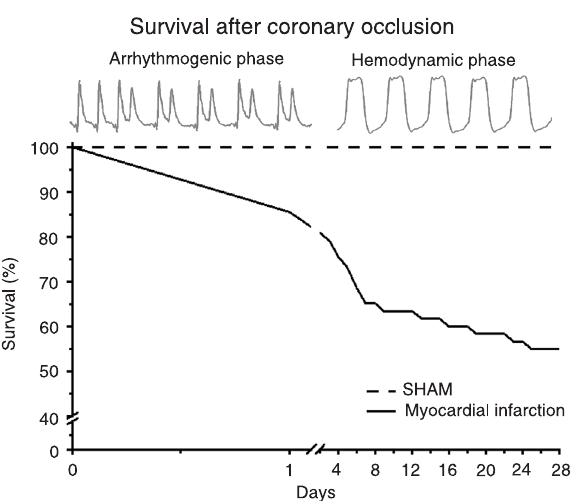
Figure 2. Distinct phases of mortality after myocardial infarction during 28 days. Kaplan-Meier curves show an initial phase (first 24 h) in which arrhythmias are the main cause of death. The second period corresponds to those animals that die by cardiac